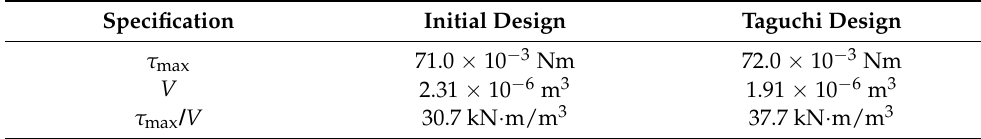
Table 8. Test results of GA and Taguchi